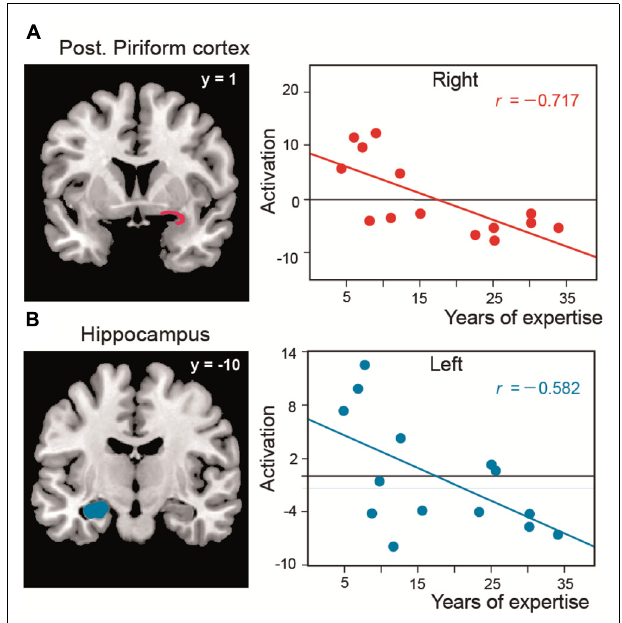
FIGURE 4 | Functional reorganization in perfumers. Significant negative correlations between the length of expertise in professional experts and the level of activation (amplitude) in (A) the posterior piriform cortices and (B) the left hippocampus (modified from Plailly etal., 2012).